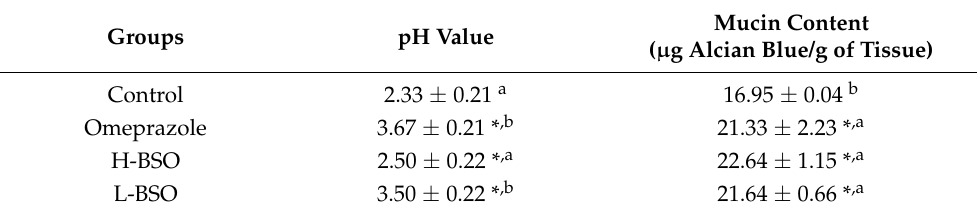
Table 1. Effect of orally administered distilled water, omeprazole, H-BSO, and L-BSO on pH value and gastric wall mucus production in the ethanol-induced gastric ulcer